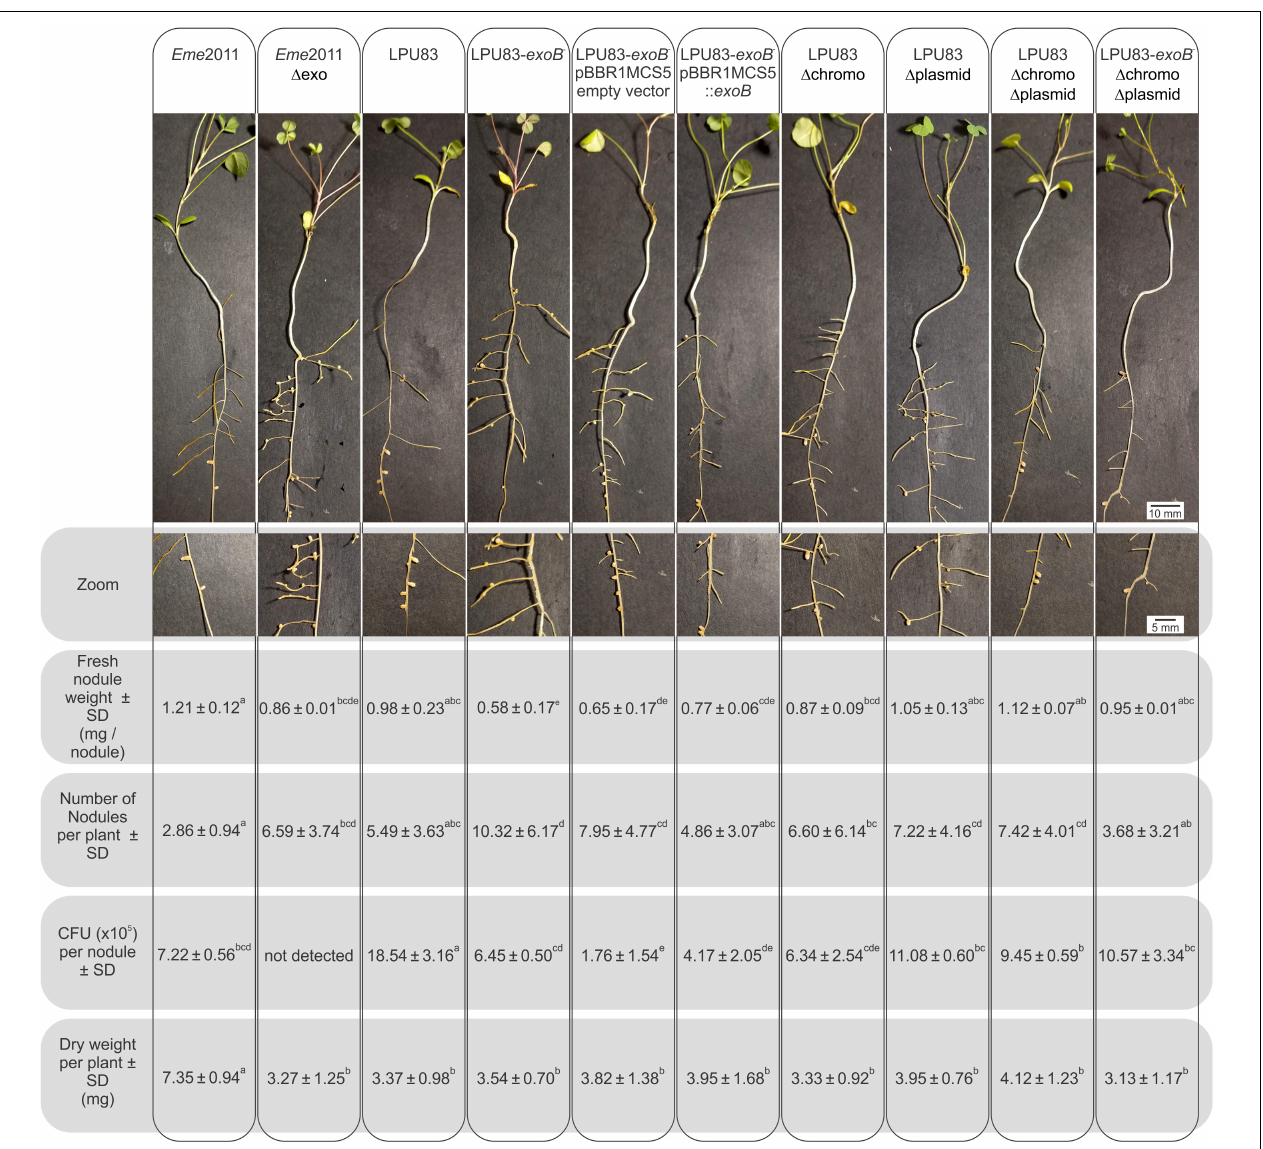
FIGURE 5 | Analysis of the nodulation of LPU83 EPS I mutant strains. M. sativa plants infected by the indicated strains were harvested at 4 weeks post-inoculation. In the top panel, a representative plant was photographed. In second panel, zoom on the nodules of each plant was made. The number of nodules per plant were counted and weighted. Nodules were surfaced-sterilized, then crushed in sterile isotonic solution followed by plating on TY with the corresponding antibiotics and after 2 days CFU were counted. The shoot dry weight per plant was measured. Non-inoculated roots did not show nodules and the dry weight per plant was 3.98 ± 0.78 b . Results were statistically analyzed by the ANOVA and least significant difference tests (Box et al., 1978). Values followed by different letters differed significantly with p < 0.05.